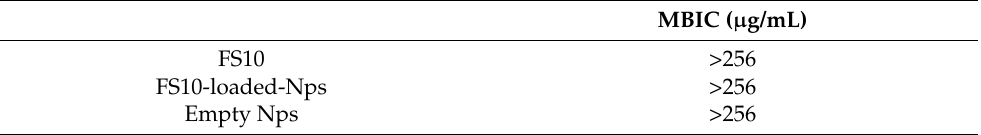
Table 4. Determination of the MBIC of FS10, FS10-loaded-Nps, and empty Nps versus S. aureus ATCC 43300. Results represent the mean of two independent experiments performed in